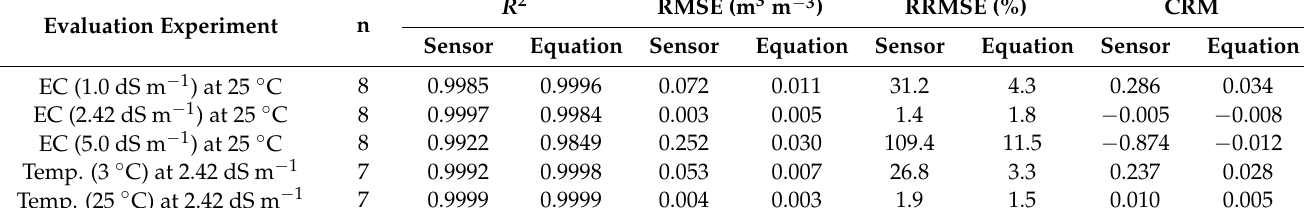
Figure 9. Comparison between actual VWC values measured by gravimetric method and calculated by L&O equation in graded increasing soil moisture at three levels of ( a ) EC and ( b ) temperature. Table 8. Statistics results of testing proposed L&O correction equation vs. actual VWC values at three salinity levels, and temperature impact on sensor readings of VWC (m 3 m − 3 ) in gradually increasing soil moisture as determined by R 2 , RMSE, RRMSE, and CRM.